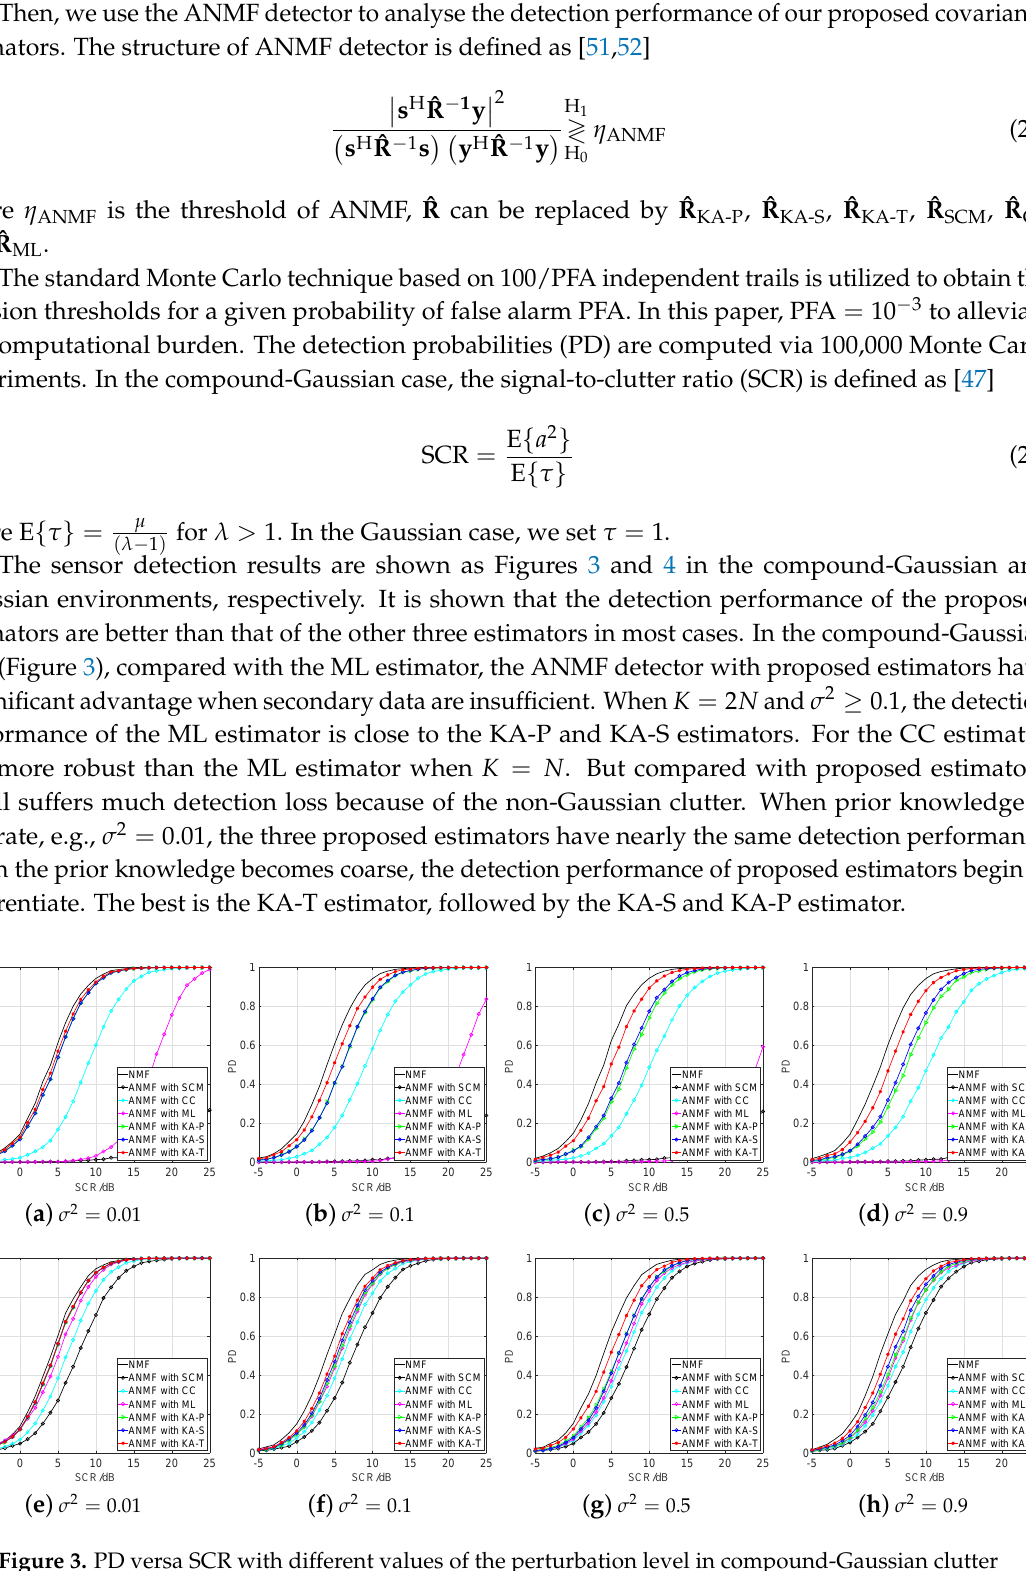
Figure 3. PD versa SCR with different values of the perturbation level in compound-Gaussian clutter PFA = 10 − 3 , ( a – d ) K = 1 N ; ( e – h ) K = 2 N